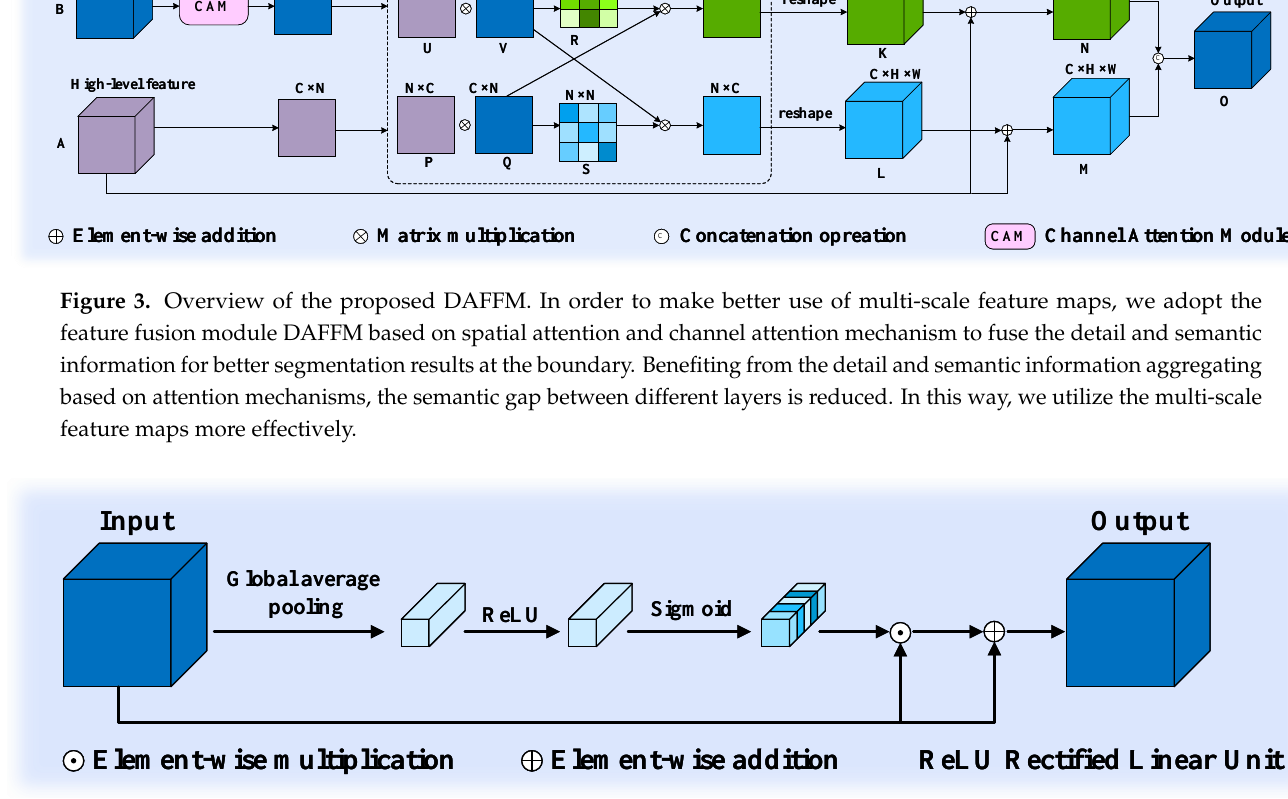
Figure 4. Overview of the implied channel attention module. The CAM utilizes a global average pooling layer and sigmoid function to generate the weight vectors. In this way, we re-weigh feature maps to improve the consistency of different channels for better segmentation